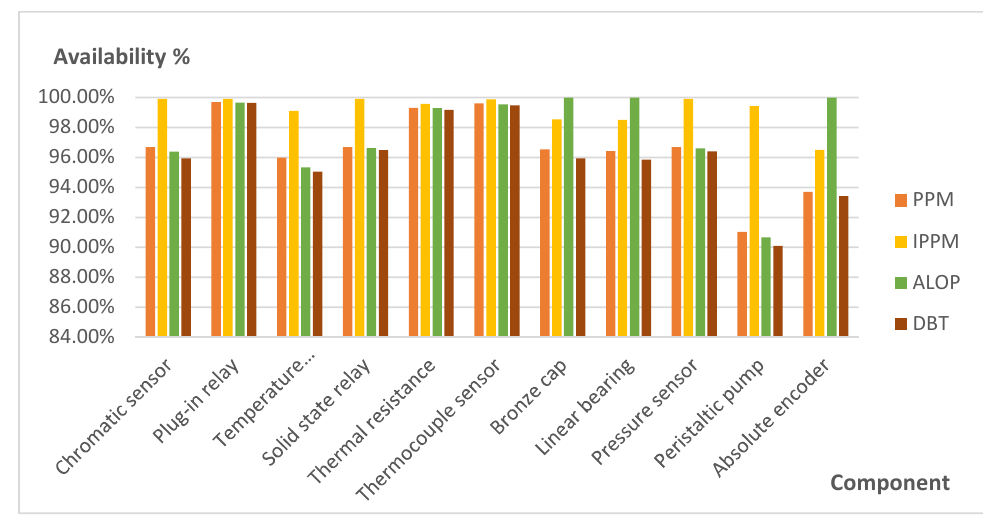
Figure 9. Comparison of availability values in affected components.